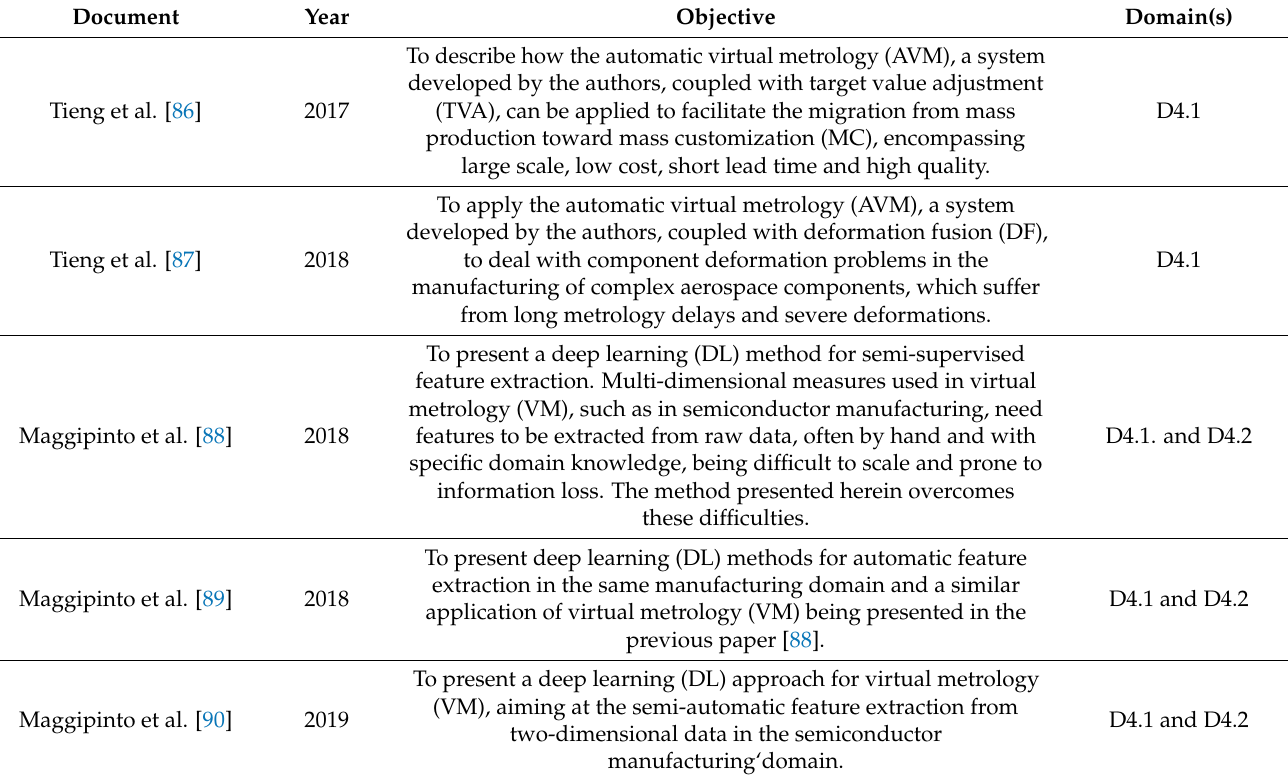
Table 7. Documents reviewed in the “Metrology for Simulations and Virtual Measuring Instru- ments”